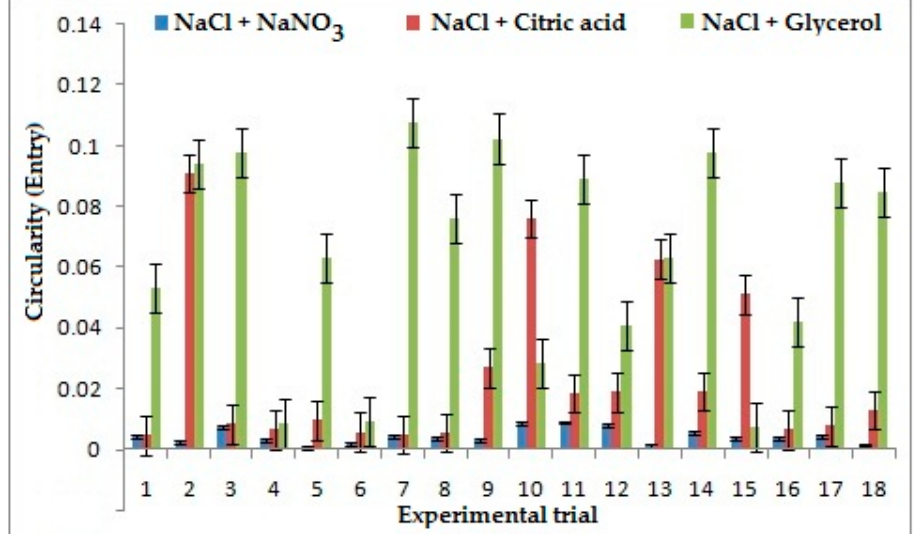
Figure 6 . Effects of electrolytes and process parameters on circularity at entry .